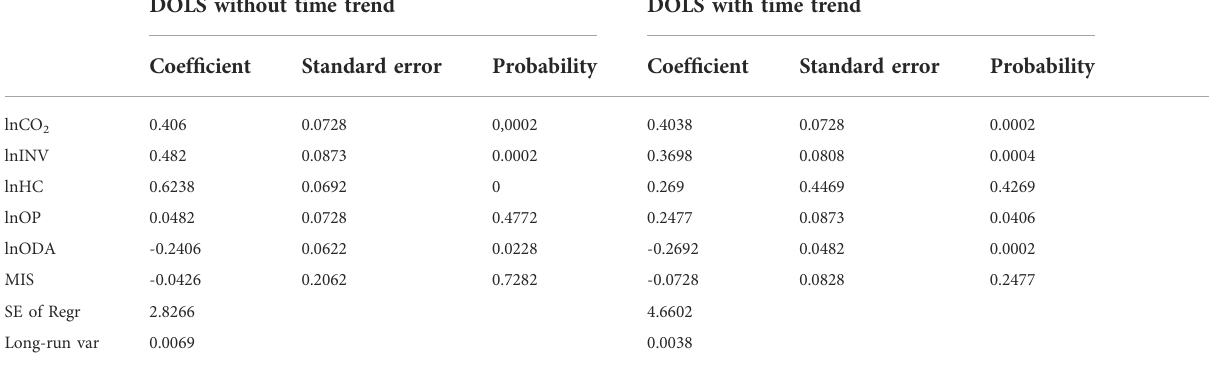
TABLE 9 Group-mean panel DOLS estimation results for the growth model.